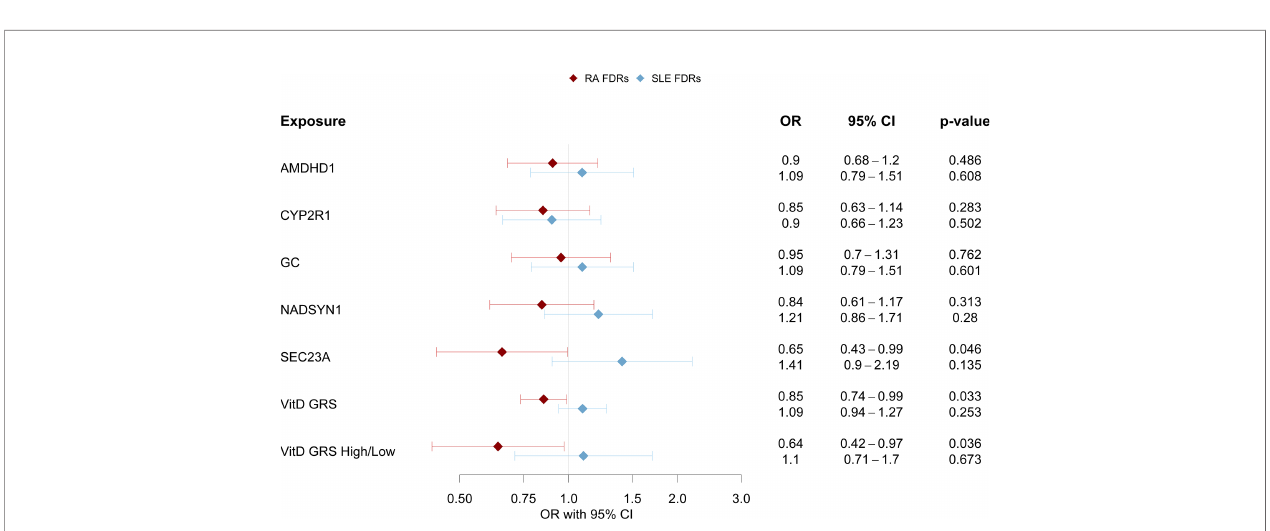
FIGURE 2 | Vitamin D GRS Association with Cohort Speci fi c aAb+. For different vitamin D level measures (either individual SNPs, vitamin D GRS, or dichotomized vitamin D GRS), the odds ratio (OR) is shown as the dot and the corresponding 95% con fi dence interval is the line. The RA FDR cohort is in red and SLE FDR cohort in blue.